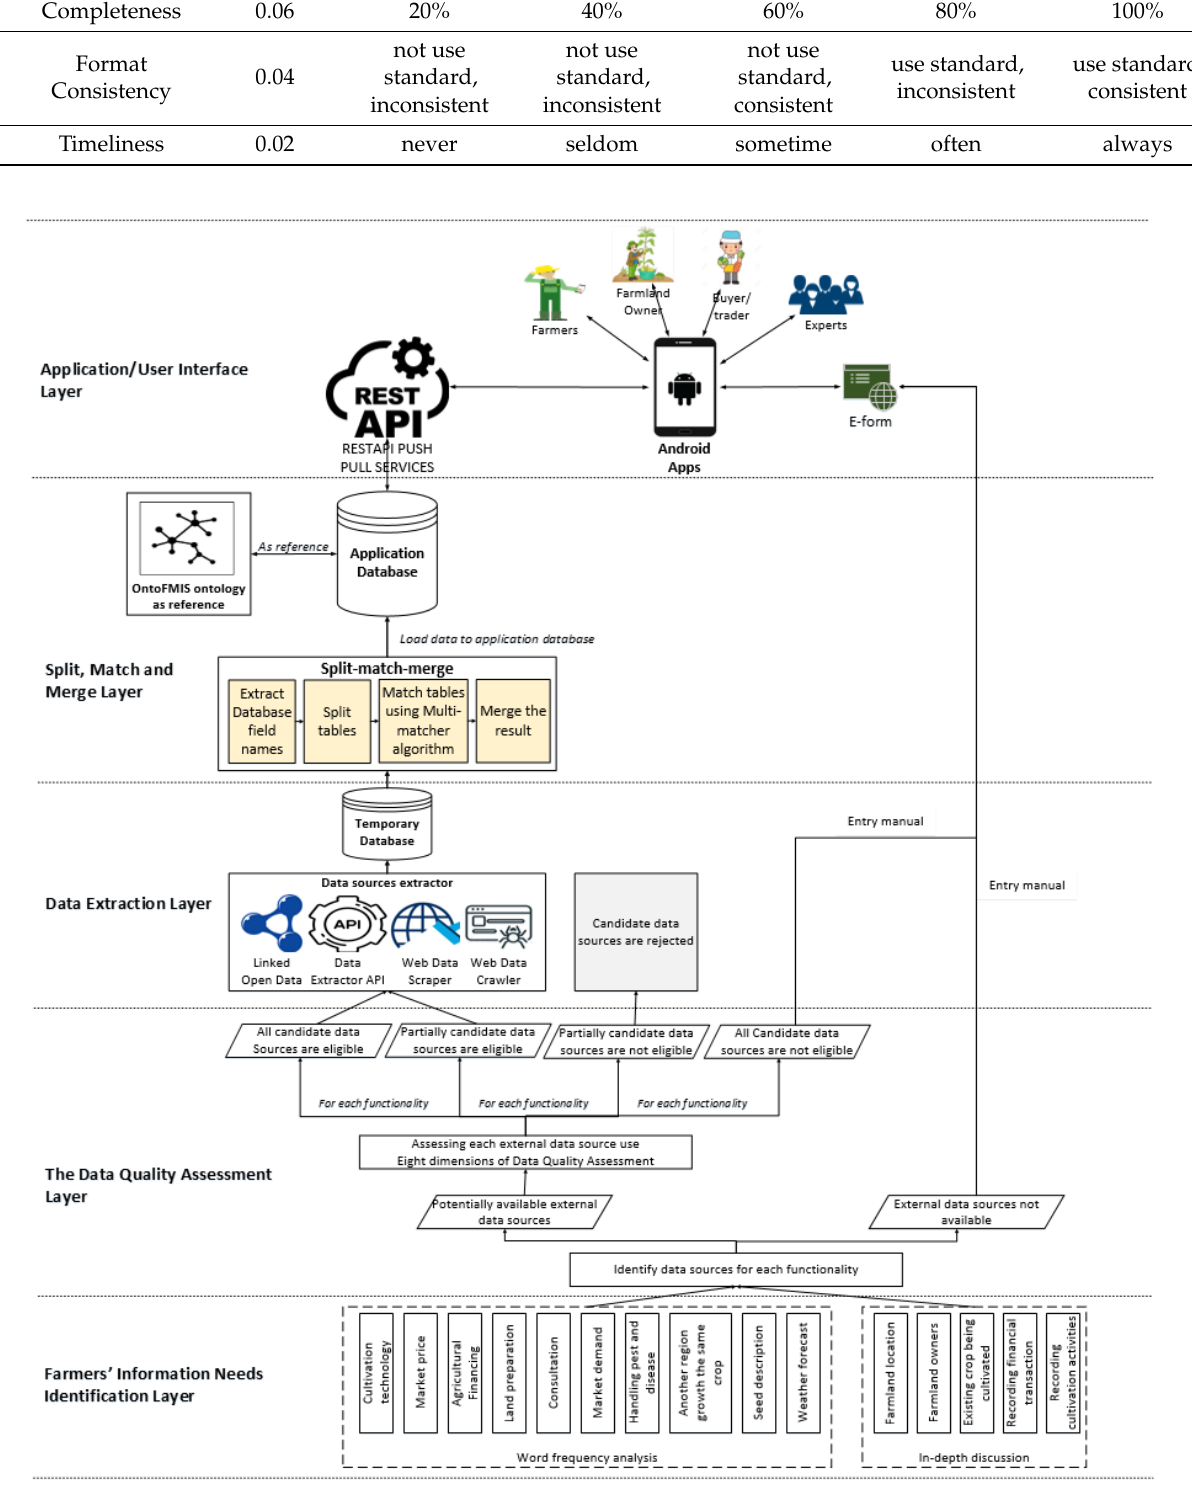
Figure 4. The small Farm Management Information System Conceptual Model for Indonesian Chili Farmers. Table 4. The eight dimensions of data quality assessment in Small Farm Management Information System.